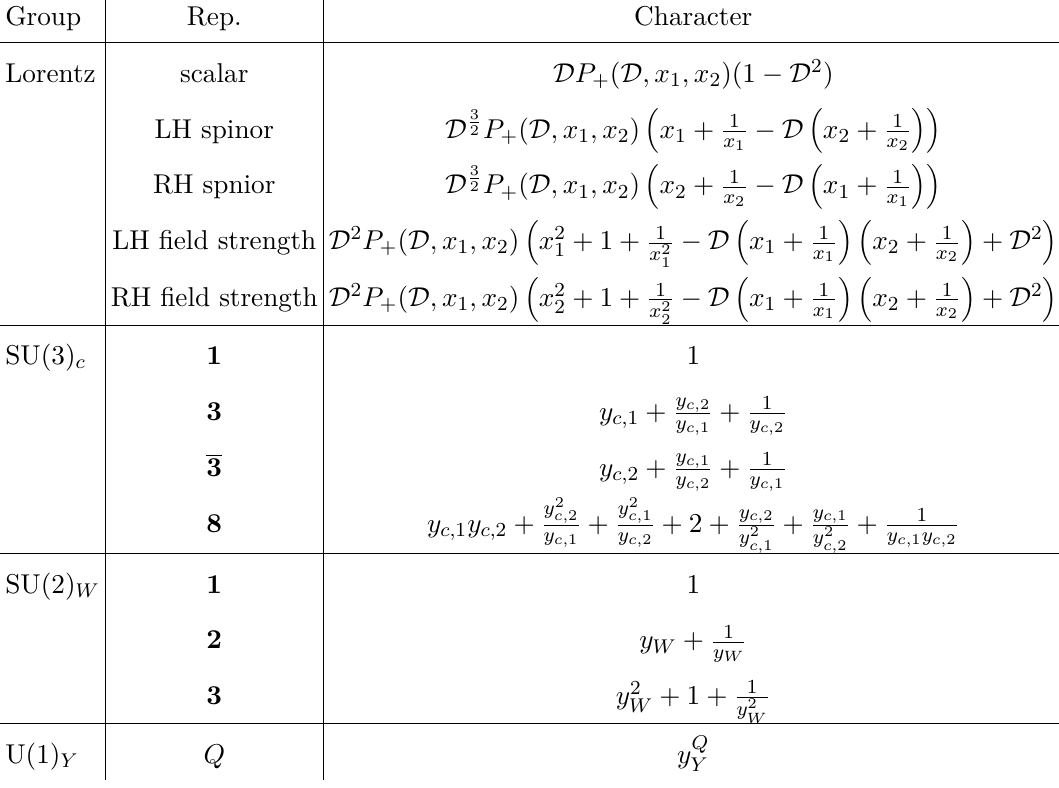
( D , x ) is given by eq. (3.26). + 1 , x 2